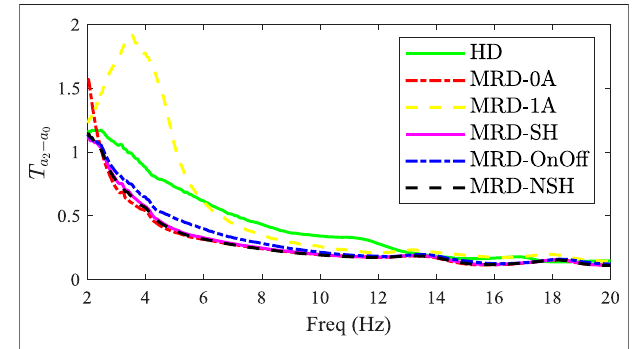
FIGURE 13 | The results of the 2 – 40 Hz frequency sweep